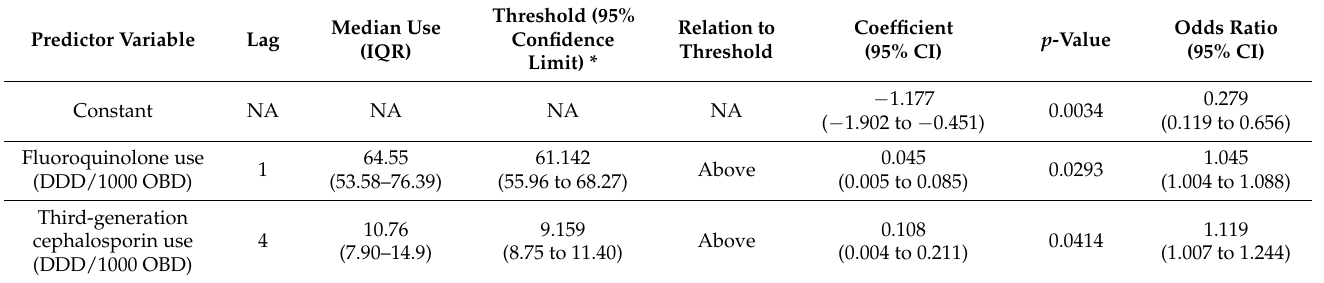
Table 1. Threshold logistic result in modeling ESBL-producing E. coli incidence rates at 60th percen-